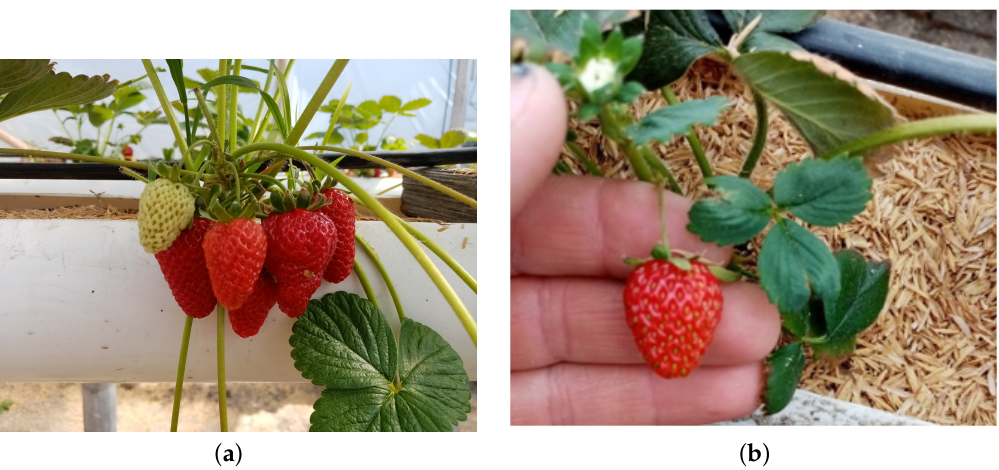
Figure A2. ( a ) Cultivation with fuzzy control irrigation system. ( b ) Cultivation with fixed timed irrigation